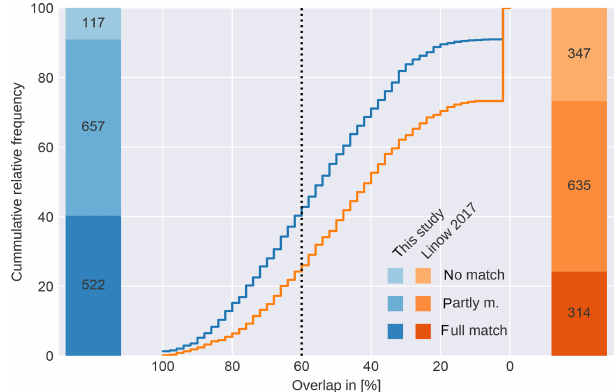
Figure 5. Evaluation of the detection algorithm presented in this study and the original algorithm (Linow and Dierking, 2017) against handpicked LKFs. The cumulative frequency of occurrence of the overlap is given in the center plot. The number of features is given in the bar plots for each class (fully matching, partly matching, and not